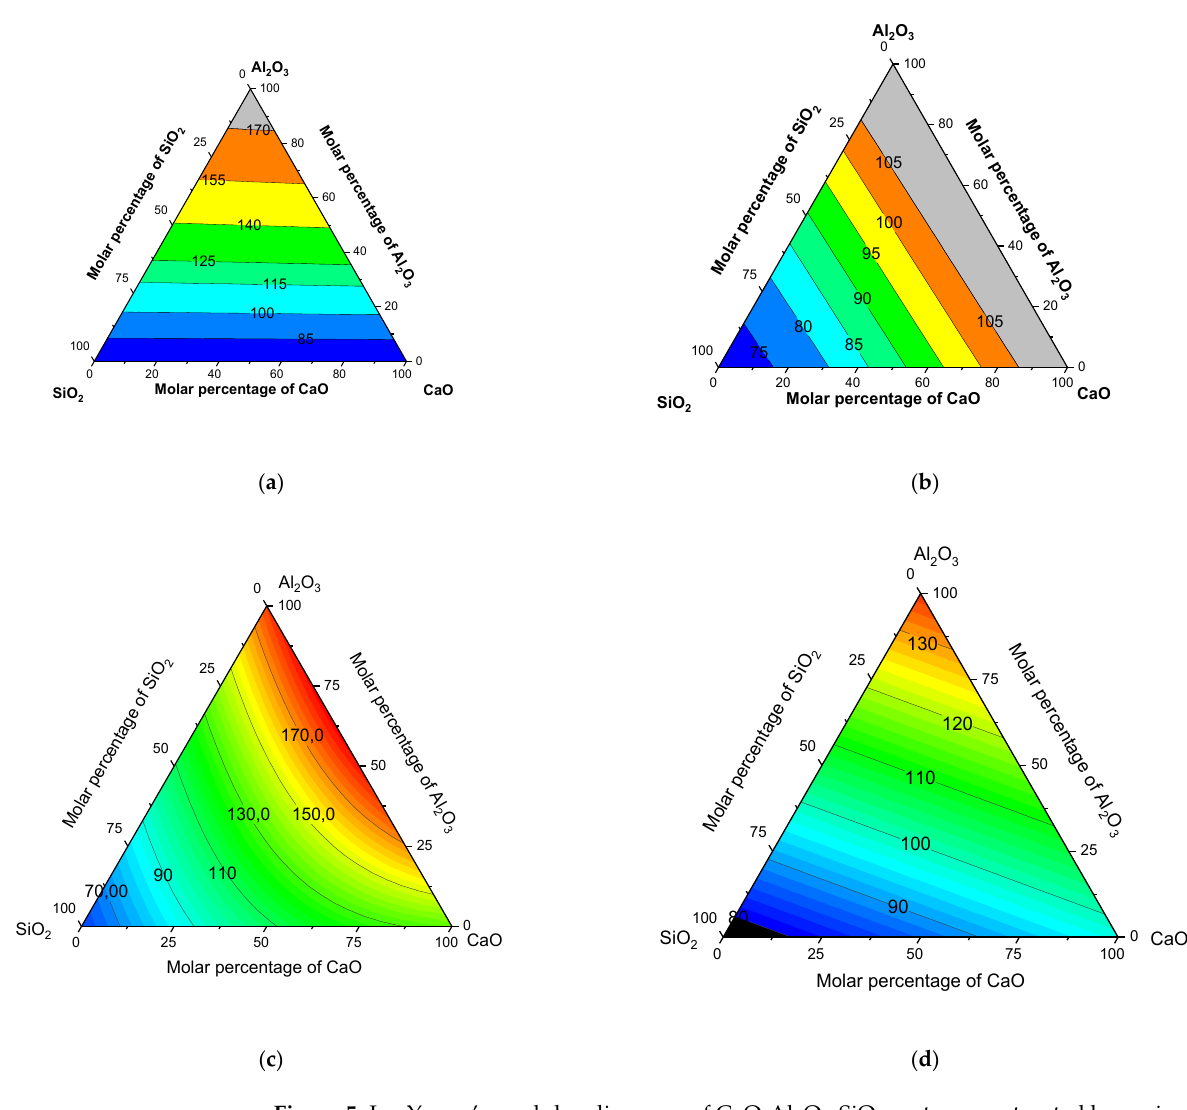
Figure 5. Iso-Young’s modulus diagrams of CaO-Al 2 O 3 -SiO 2 system constructed by various equa- tions. ( a ) Winkmann–Schott. ( b ) Appen. ( c ) Ashizuka–Zhang. ( d ) Modified Appen.